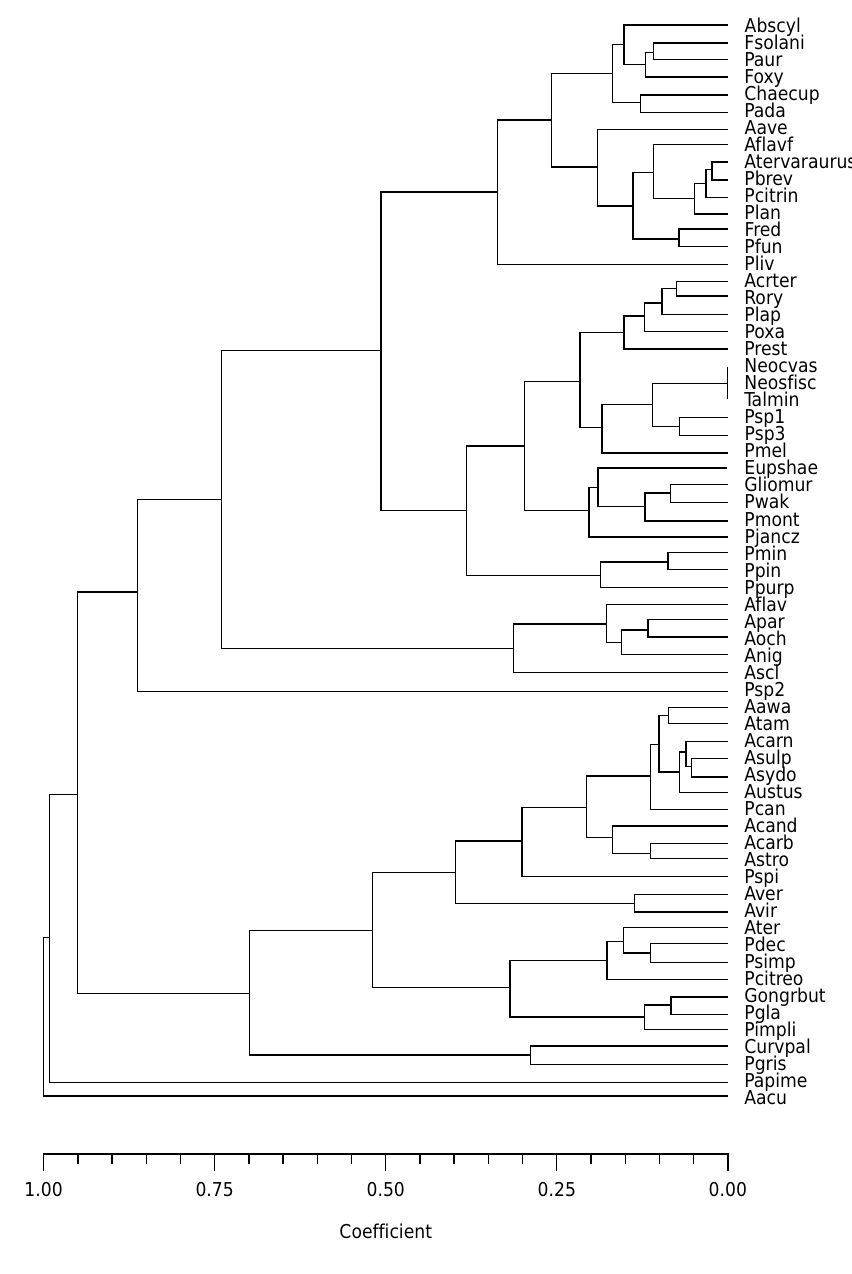
Figure 3. Proximal dendrogram among filamentous fungi species from a Preserved and Anthropized area of the Parna Catimbau, Caatinga , Pernambuco, Brazil. Statistical